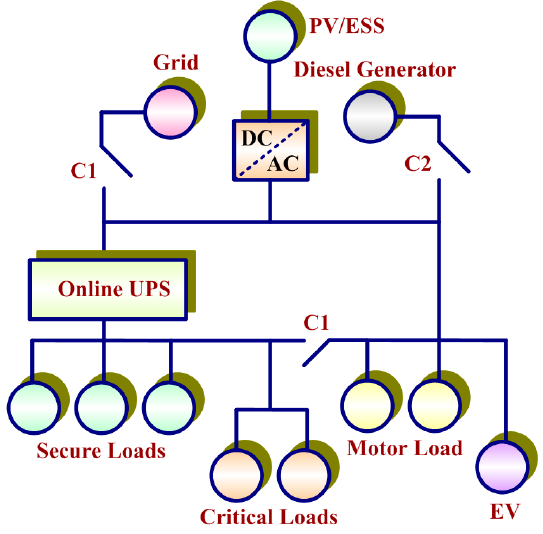
Figure 1. Proposed microgrid architecture under consideration.